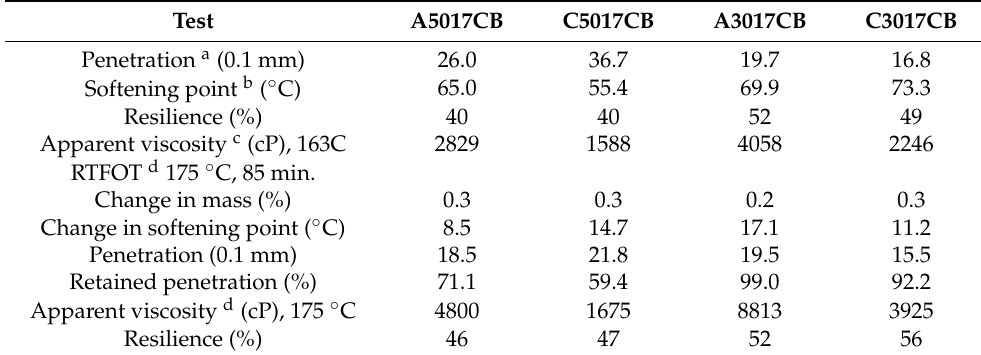
Table 7. Results of the continuous blend asphalt rubber characterization tests.